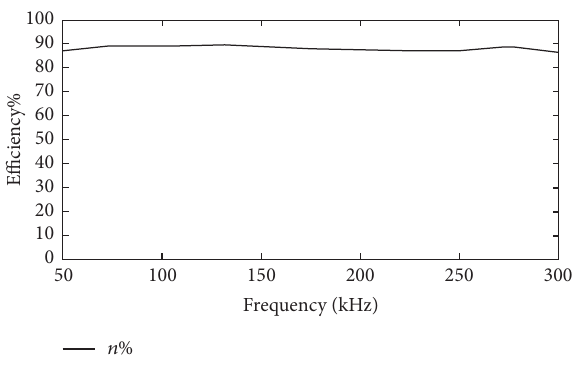
Figure 12: The efficiency versus